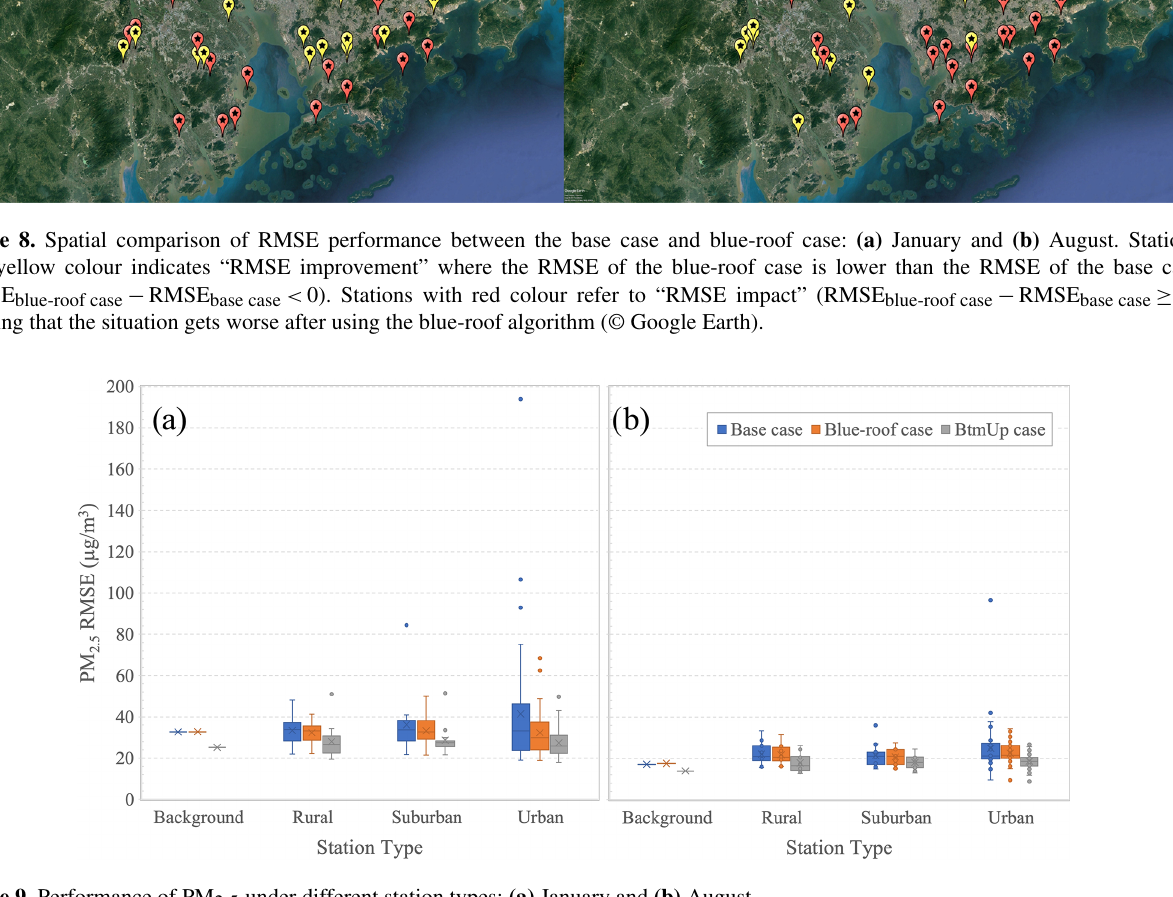
Figure 9. Performance of PM 2 . 5 under different station types: (a) January and (b)